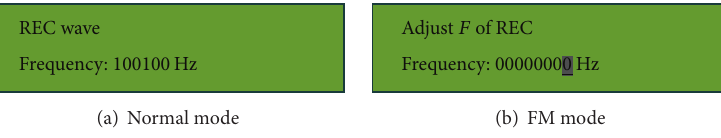
Figure 21: The LCD working sketches under the state of sinusoidal wave.